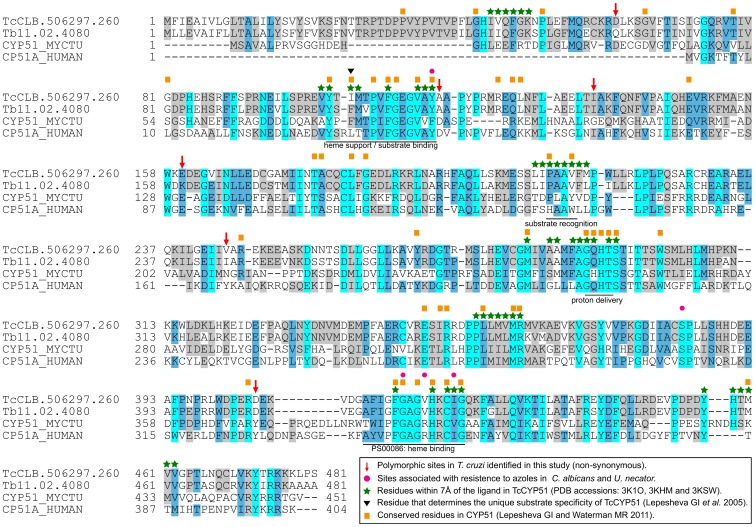
Alignment of T. cruzi, T. brucei, M. tuberculosis and human Lanosterol 14-α demethylases, showing the non-synonymous changes identified in this work (red arrows).Important residues either in Tc14DM or in the CYP51 family are noted [100], [101], as well as residues associated with resistance to azoles in C. albicans and U. necator
[56], [57]. PS00086 is the Prosite Cytochrome 450 motif (cysteine heme-iron ligand signature).